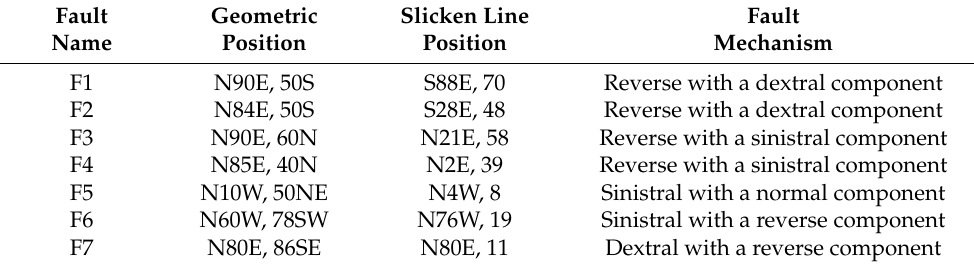
Figure 4. Geological map of the northern Birjand mountain range. Table 1. The kinematic and geometric location of faults identified in the study